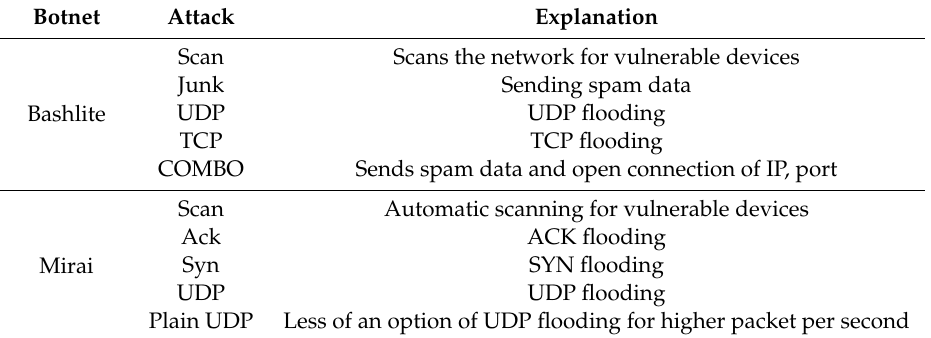
Table 6. Botnet and attack types used in this study.